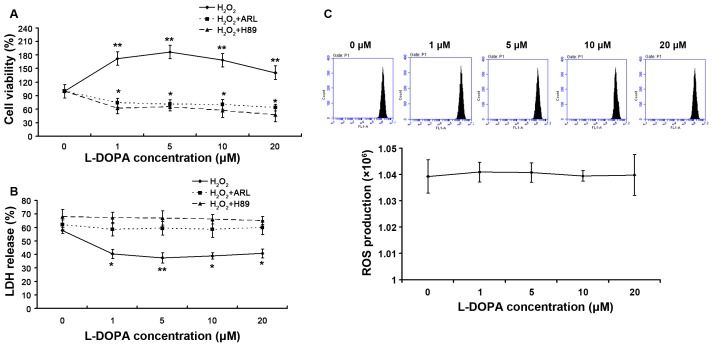
Effect of low dose L-DOPA with or without CD39 inhibitor pre-treatment on the oxidative stress (χ±σ, n = 10).PC12 cells were seeded into 96-well plates (5×103/well; 200 µl/well) and divided into two groups: L-DOPA treatment group and CD39 inhibitor pre-treatment group (cells were pre-incubated with 0.5 mM ARL 67156 for 30 min or 10 µM H89 for 1 h before L-DOPA treatment). Cells were incubated with L-DOPA at different concentrations (0, 1, 5, 10 and 20 µmol/L) for 3 days. On the fourth day, cells were incubated with 100 µmol/L H2O2 for 8 h. MTT assay and LDH assay were performed to determine the viability of PC12 cells. (A) The cell viability with or without CD39 inhibitor pretreatment was detected by MTT assay. Results showed the viability increased as compared to untreated group, while H89 and ARL eliminated this effect. (B) The cell viability was detected by LDH assay. Results showed that the LDH content in L-DOPA treated groups was lower than that in untreated group, while H89 and ARL eliminated this effect. (C) Intracellular ROS level was measured. H2O2 could induce oxidative stress. **P<0.01, *P<0.05 vs 0 µmol/L L-DOPA group.